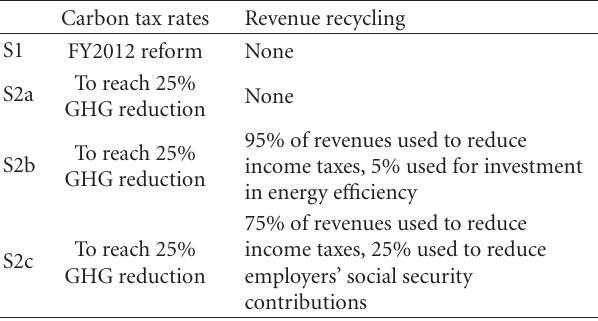
Table 2: Summary of scenarios.